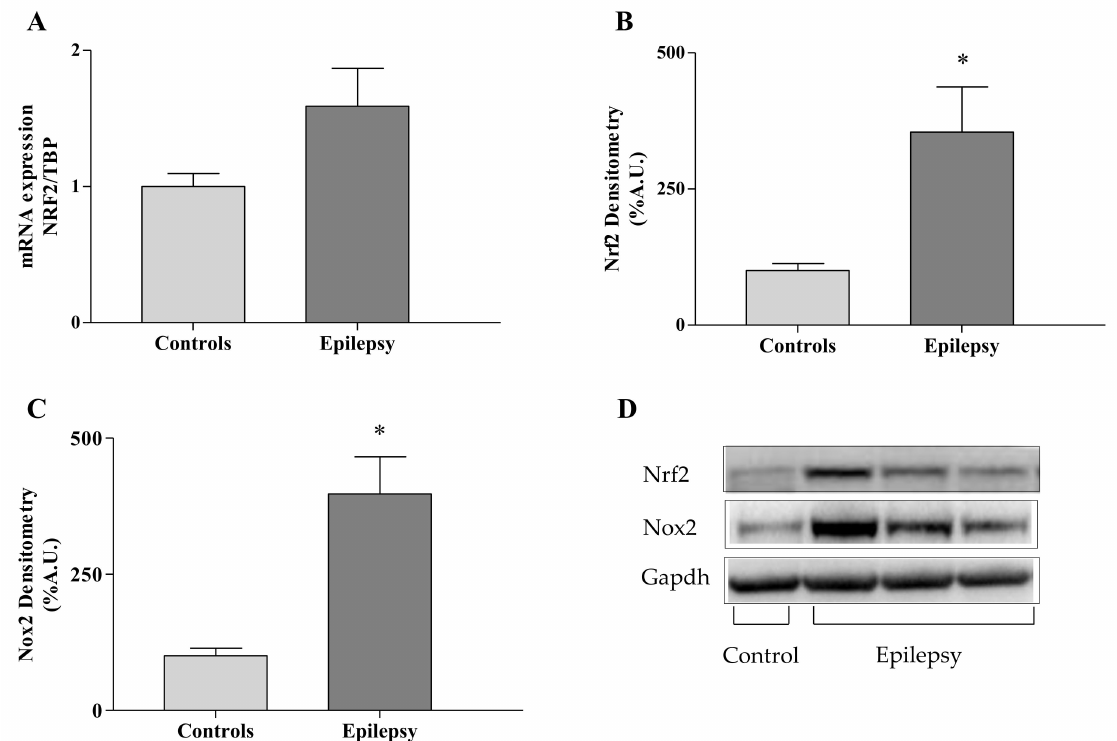
Figure 4. NRF2 and NOX2 expression in leukocytes of n = 83 children with epilepsy and in n = 44 controls. NRF2 mRNA ( A ) and protein amount ( B , D ), were determined by qRT-PCR and Western blot, respectively. NOX2 protein levels ( C ), as detected by Western blot analysis ( D ). Values are expressed as median ± SEM. Statistical significance is defined as * p < 0.05, respect to